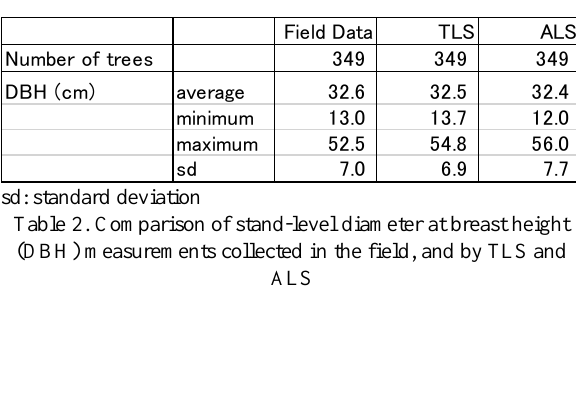
Individual levcl : Table 3 and Figure 3 show the comparison of individual-level DBH measurements